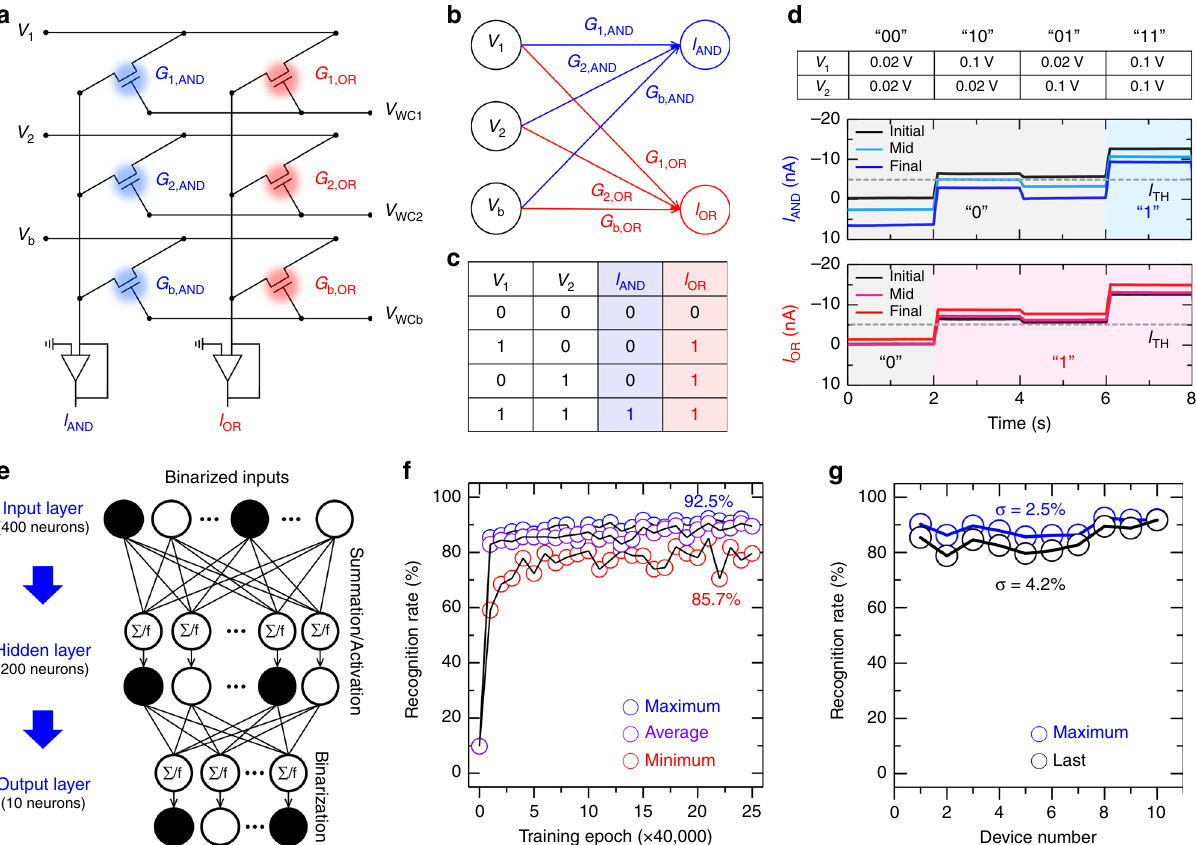
Fig. 5 Logic application of vertical synaptic device and training/recognition processes. a Schematic illustration of AND and OR logic gates implemented using proposed synaptic array with size of 2 × 3. b Simpli fi ed diagram of NN for AND and OR logic gates. c Truth table of AND and OR logic gates. d Real- time training and classi fi cation of AND and OR gates using implemented synaptic array. e Schematic illustration of two-layer perceptron-based ANN with size of 400 × 200 × 10. f Recognition rate as a function of number of training epochs for 10 synaptic devices; the maximum, average, and minimum recognition rates are indicated in blue, purple, and red, respectively. g Maximum (blue) and fi nal (black) recognition rates of 10 synaptic